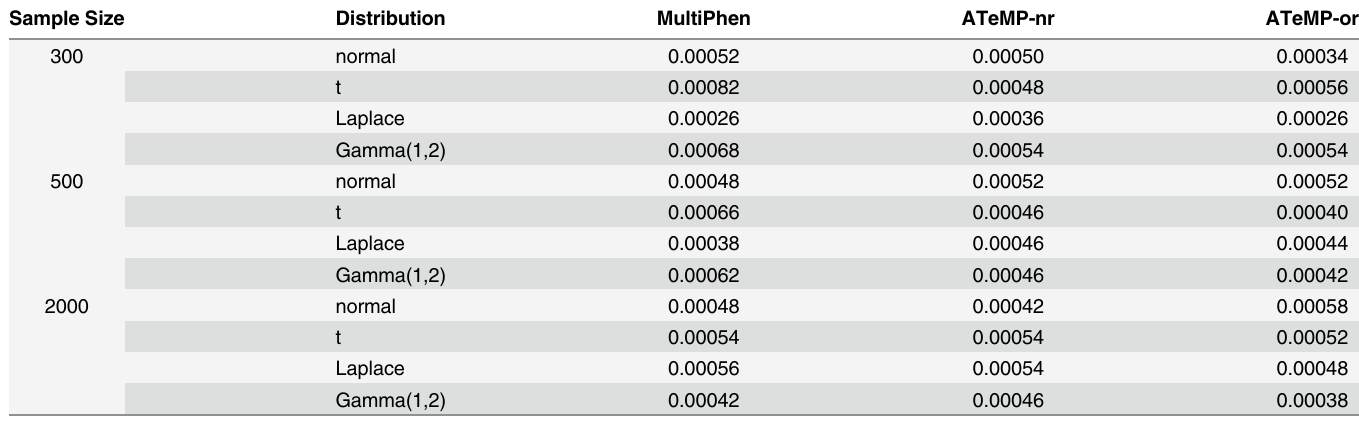
Table 2. Type I error of the multiple phenotypes association tests at the nominal significance levels of 5 × 10 − 4 when the between-phenotype corre- lation is 0.5 and the minor allele frequency of the tested locus is 5%. The sample sizes are set to be 300, 500 and 2000, respectively.